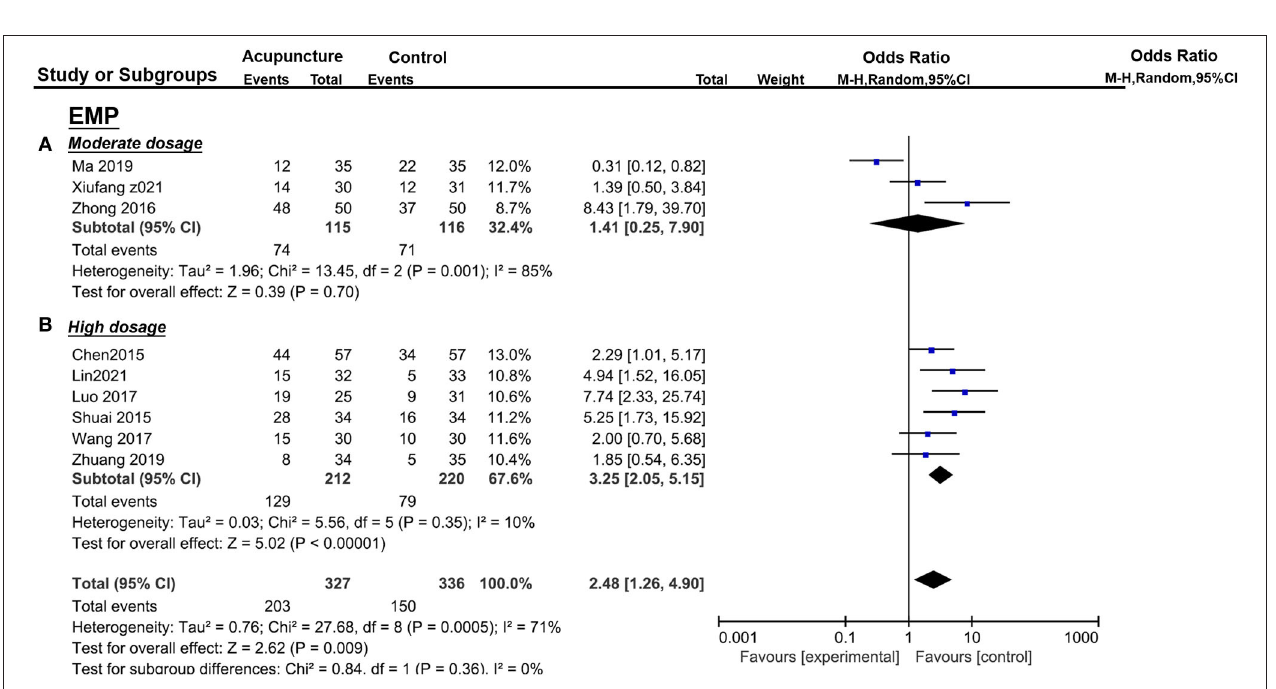
Frontiers in Public Health |